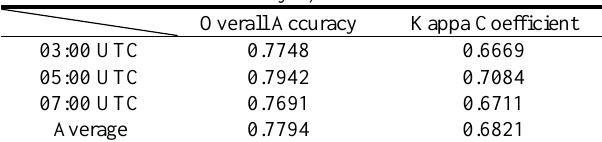
Table 2 . The Overall Accuracy and Kappa Coefficient of the supervised classification results at 3:00, 5:00, 7:00 UTC on